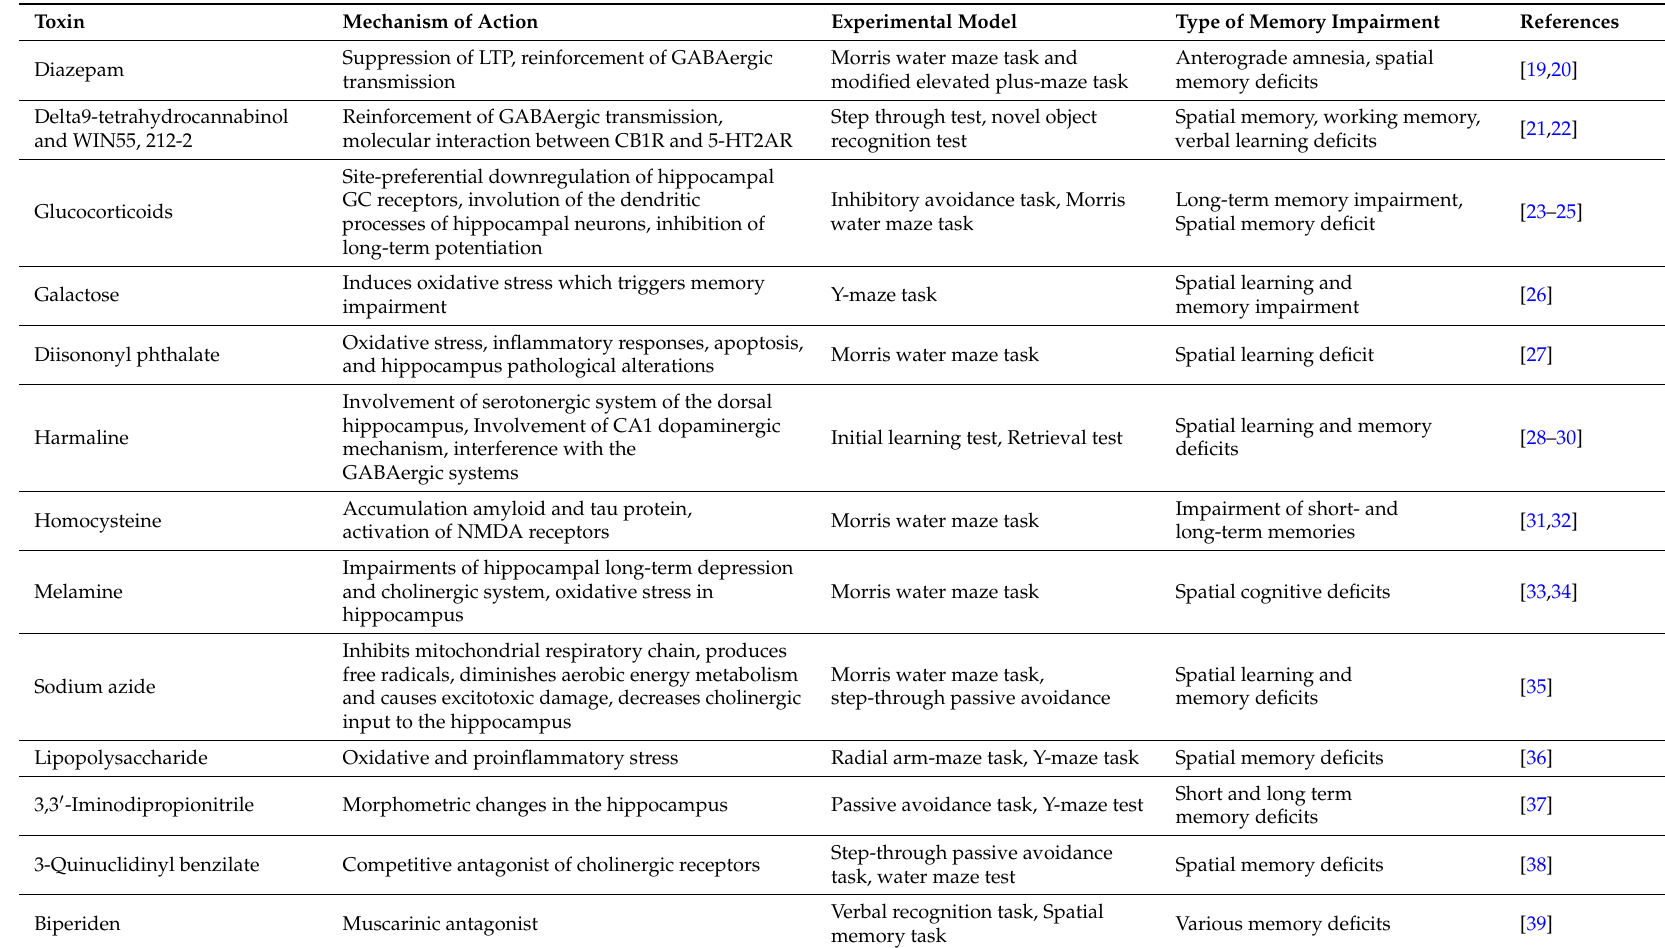
Table 1. Miscellaneous toxin-induced models for memory